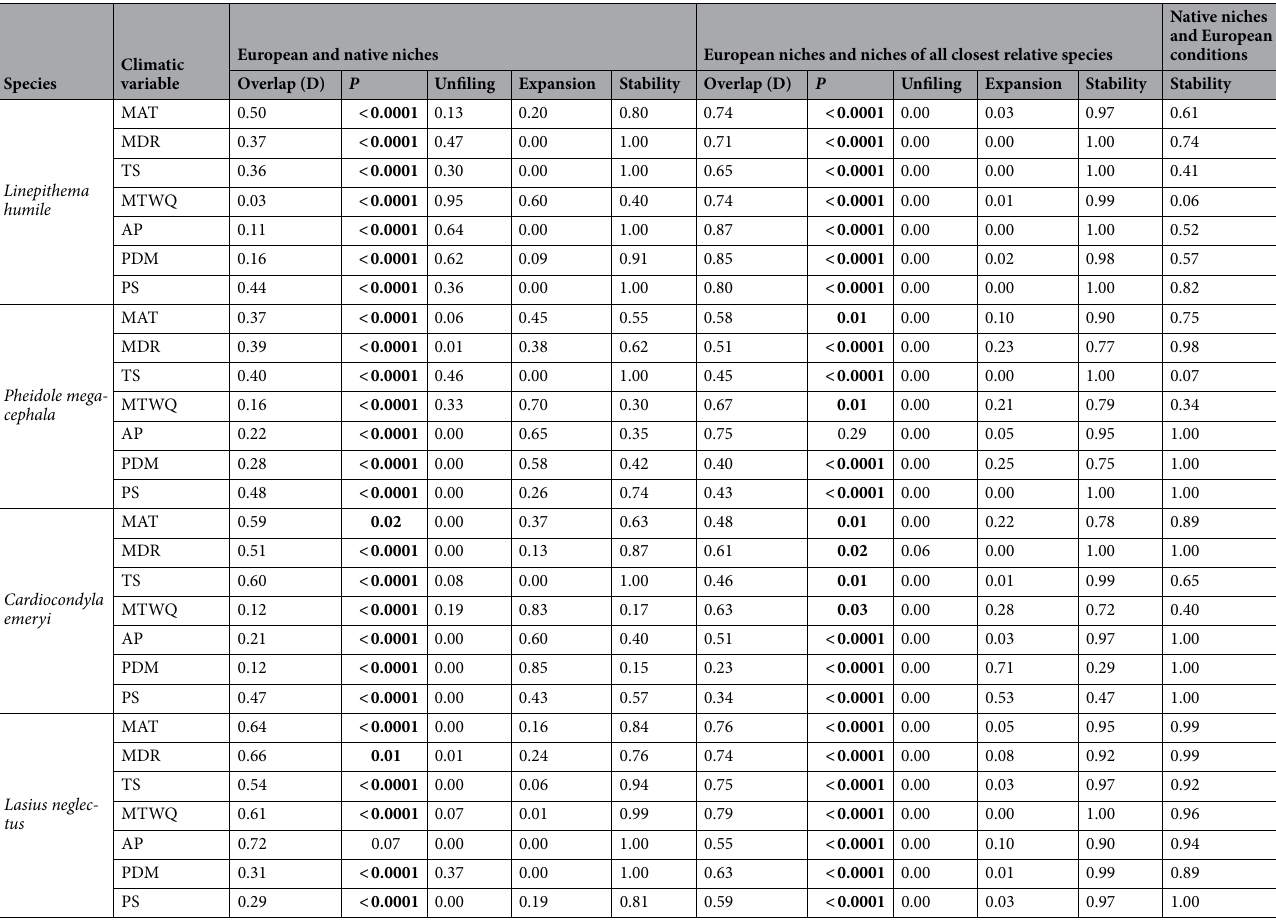
Table 2. Niche overlap (D) and its statistical significance ( P ) based on the equivalency test. For each climatic variable and introduced ant species, there were two types of comparisons: (1) a comparison of the overlap between the introduced species’ European and native climatic niches and (2) a comparison of the overlap between the introduced species’ European climatic niches and those of their closest relative species in Europe (all closest relative species combined). Niche unfilling, expansion, and stability indices were also determined for each comparison. Furthermore, for each climatic variable and introduced ant species, an additional version of the niche stability index was calculated: it quantified how the native climatic niches of introduced species fit with climatic conditions in Europe. Abbreviations: MAT mean annual temperature; MDR mean diurnal range (mean of monthly [max temp − min temp]); TS temperature seasonality; MTWQ mean temperature of wettest quarter of the year; AP annual precipitation; PDM precipitation of driest month; PS precipitation seasonality. In bold, significant values ( P < 0.05) after applying the Holm–Bonferroni